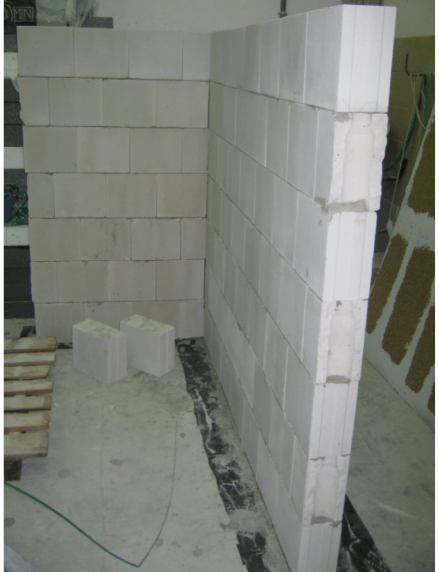
Figure 1. View of the wall before